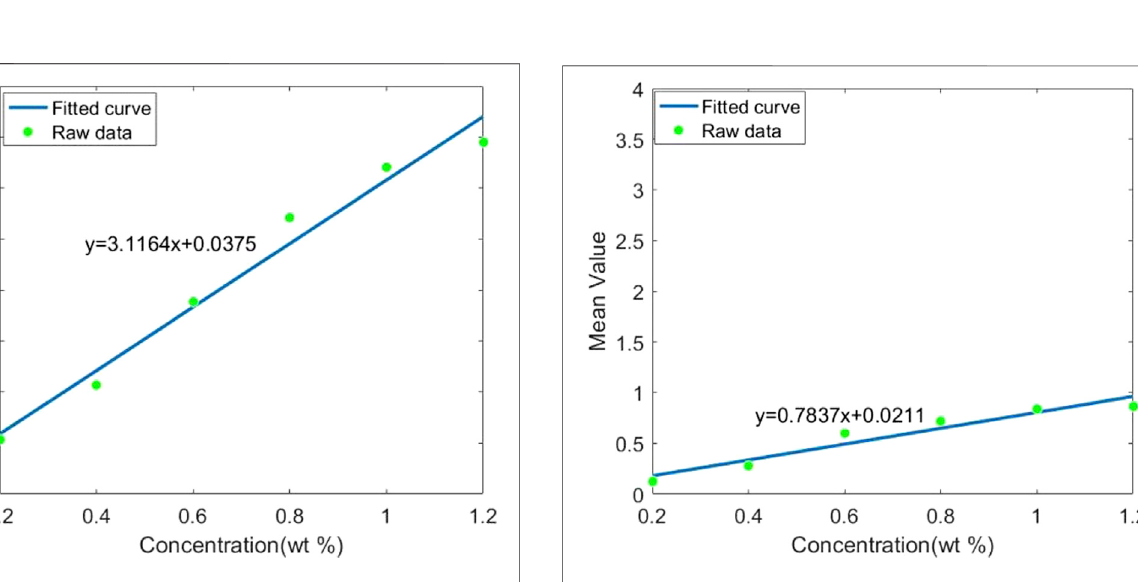
FIGURE 9 | Fluorescence ef fi ciency of Gd.